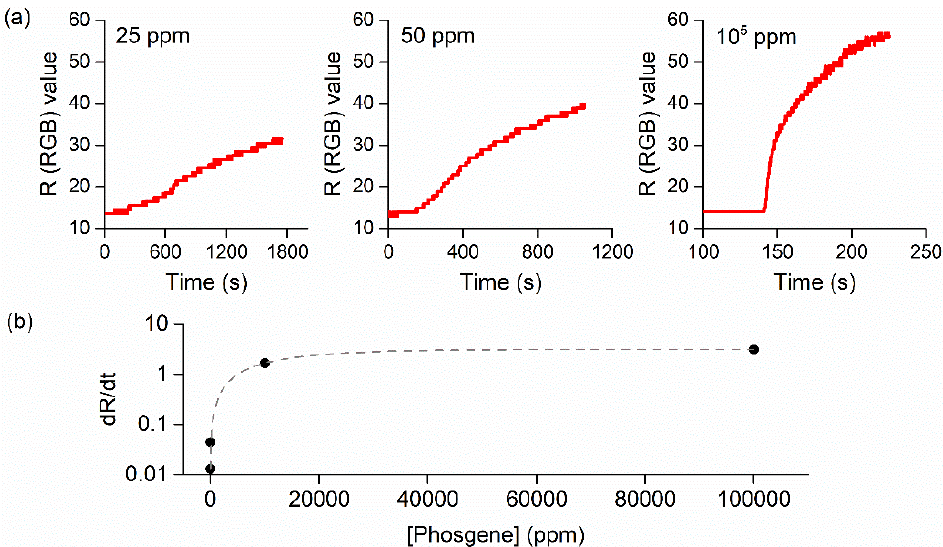
Figure 5. ( a ) Red coordinate’s kinetics for the exposure of Harrison’s reagent embedded into a screen-printed TiO 2 film to 25, 50, and 10 5 ppm phosgene. ( b ) Calibration curve of the red coordinate’s response rate as a function of the phosgene concentration. Symbols stand for experimental data. The dashed line corresponds to the exponential fit (see text for details).